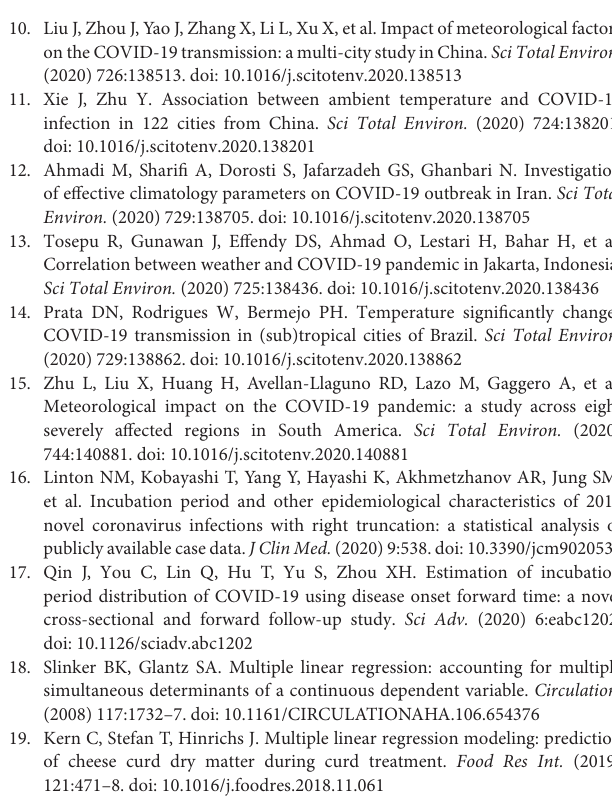
Supplementary Figure 1 | The normal P-P plot of the regression standardized residuals of the dependent variable in Wuhan (A) , Xiaogan (B) , Huanggang (C) , Suizhou (D) , Jingzhou (E) , and Huangshi (F) . Supplementary Figure 2 | The daily temperature and the DNCC in Shaoyang and Xinyang. Supplementary Figure 3 | Histogram of the regression standardized residuals of the dependent variable in Shaoyang (A) and Xinyang (D) , the normal P-P plot of the regression standardized residuals of the dependent variable in Shaoyang (B) and Xinyang (E) , and the scatter plot of regression standardized predicted values and regression standardized residuals in Shaoyang (C) and Xinyang (F) . Supplementary Table 1 | The normality test of the data in Hubei. Supplementary Table 2 | The correlations between the DNCC and the daily temperature in Shaoyang and